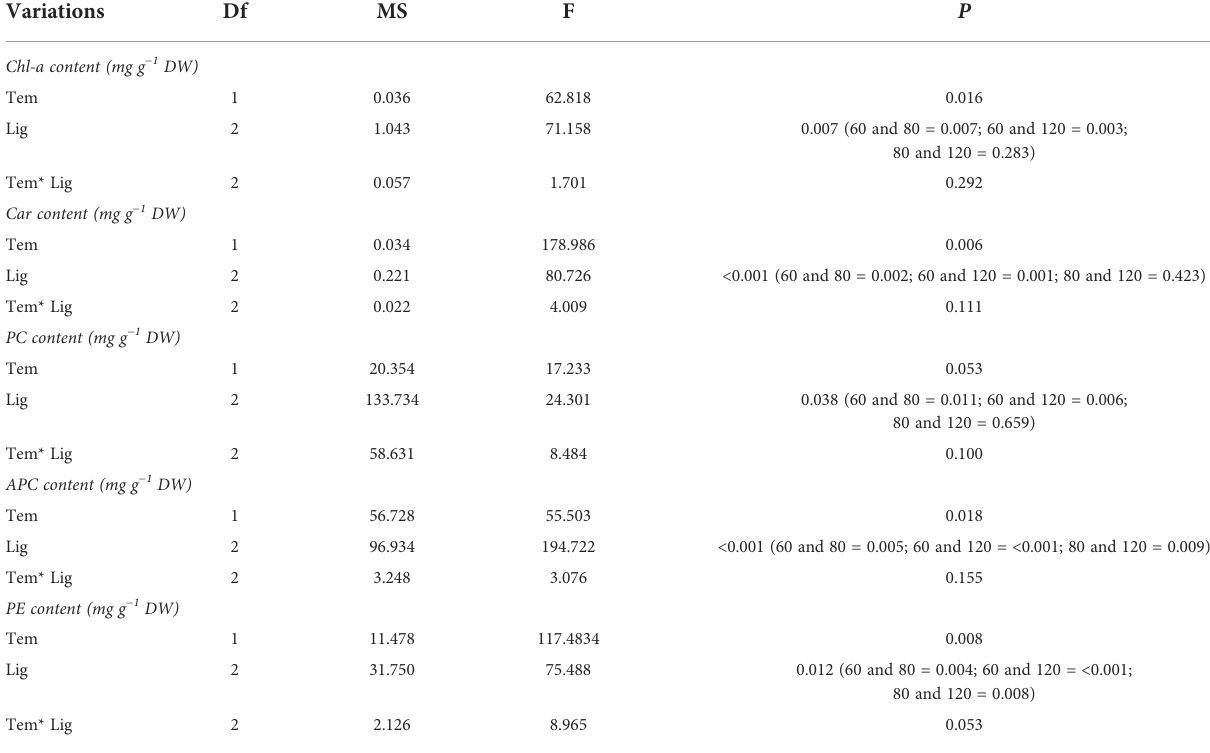
TABLE 1 Statistical analysis of Chl- a , Car, PC, APC, and PE of A. cf. fragilissima under different conditions.